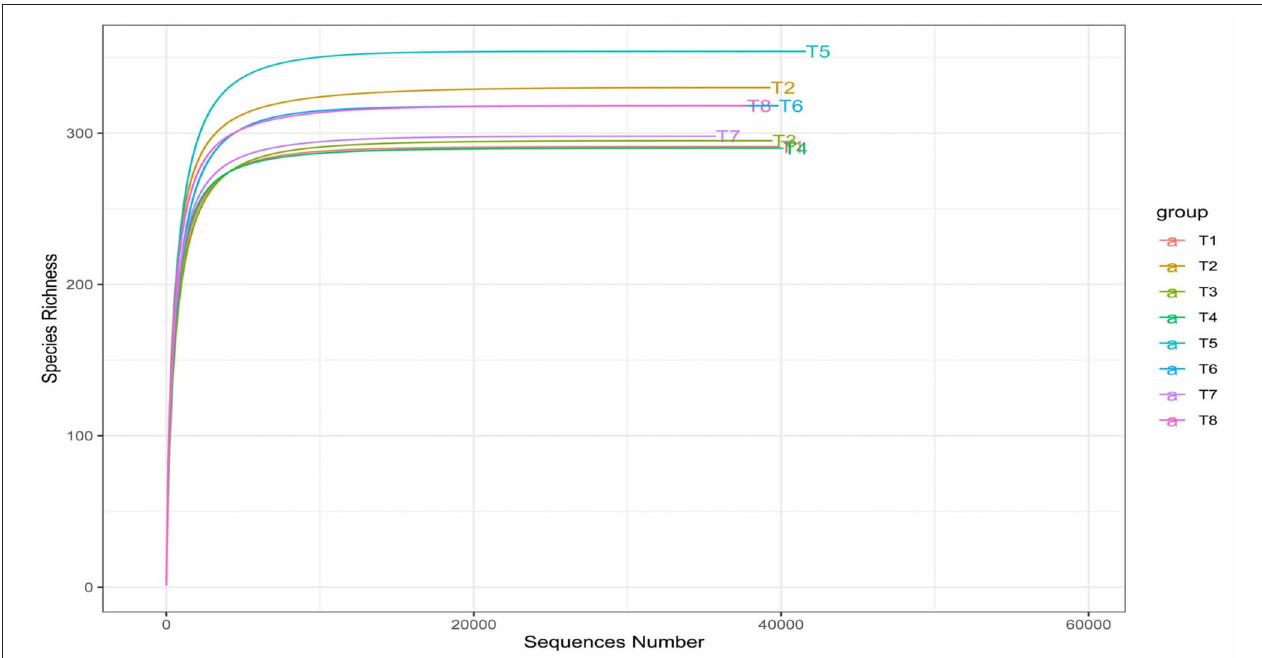
FIGURE 5 | Rarefaction curves of alpha diversity of colon mucosa microbiota. T1 = Negative control (Basal diet), T2 = Positive control [Basalt diet + 0.01% (w/w) Oxytetracycline], T3 = Basal diet + 0.2% (v/w) postbiotic TL1, T4 = Basal diet + 0.2% (v/w) Postbiotic RS5, T5 = Basal diet + 0.2% (v/w) paraprobiotic RG11, T6 = Basal diet + 0.2% (v/w) postbiotic RI11, T7 = Basal diet + 0.2% (v/w) paraprobiotic RG14, T8 = Basal diet + 0.2% (v/w) paraprobiotic RI11. T5 had the highest species richness above 300 detected little above 40,000 sequencing read